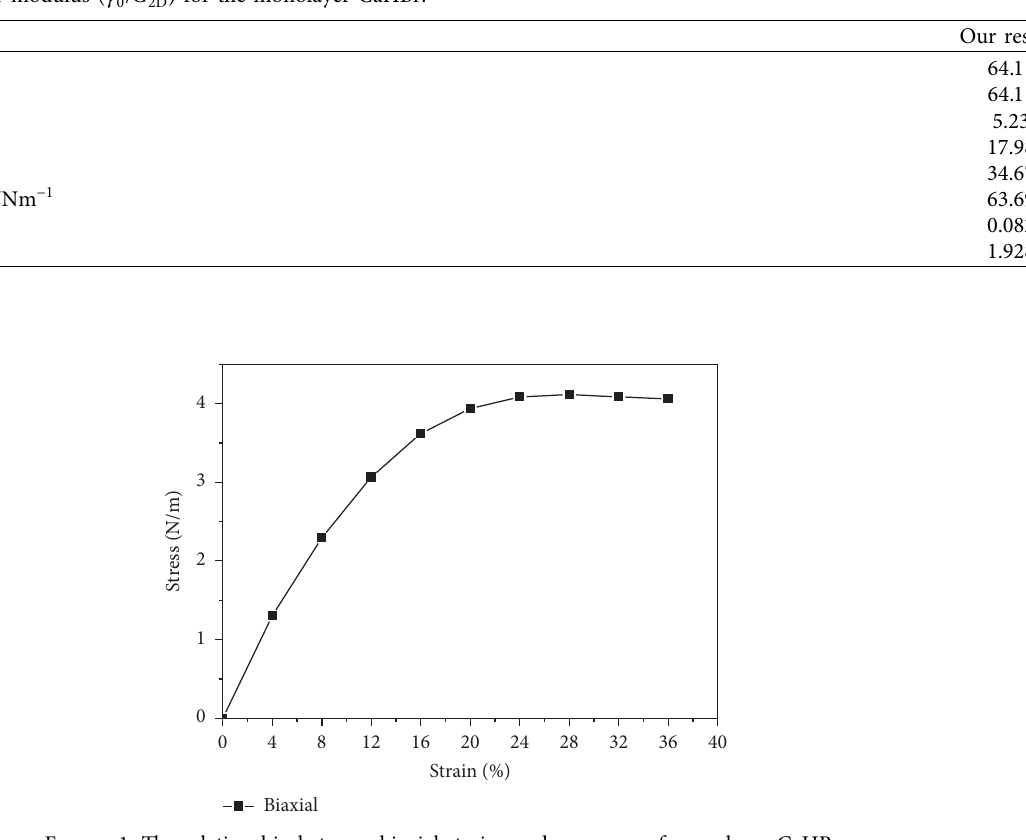
, Young’s modulus Y 2D , Poisson’s ratio ] , the ratio of layer 0